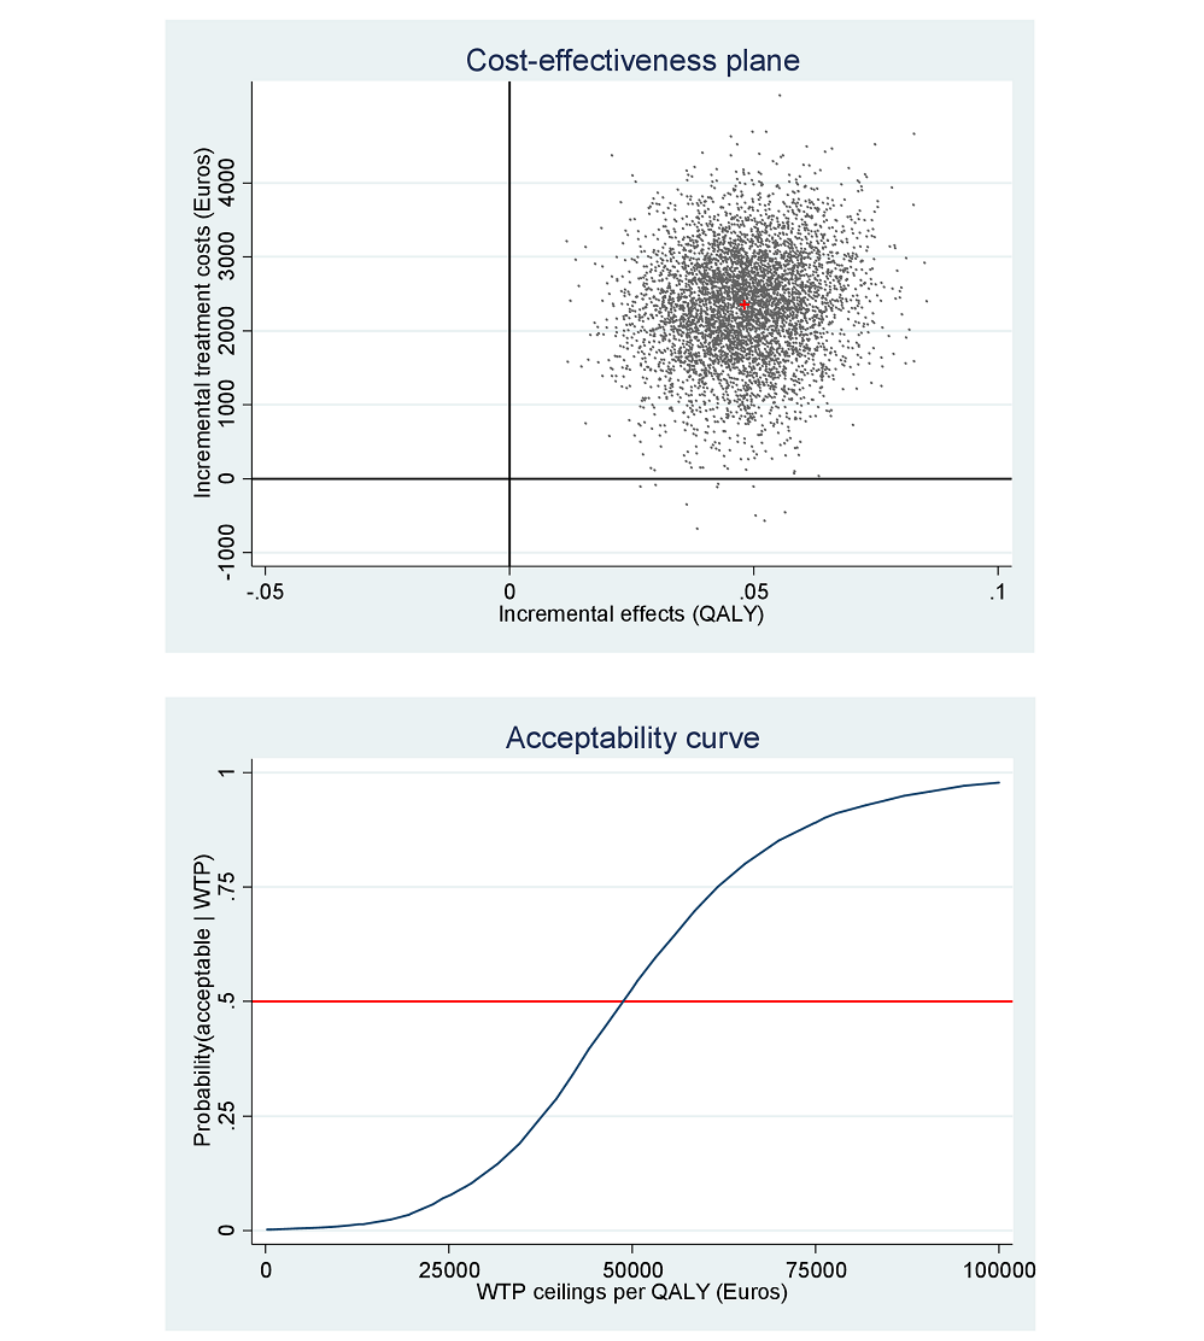
Figure 5. Cost-effectiveness plane and willingness to pay (WTP) acceptability curve for quality-adjusted life year (QALY) gain (costs per QALY gained) after 6